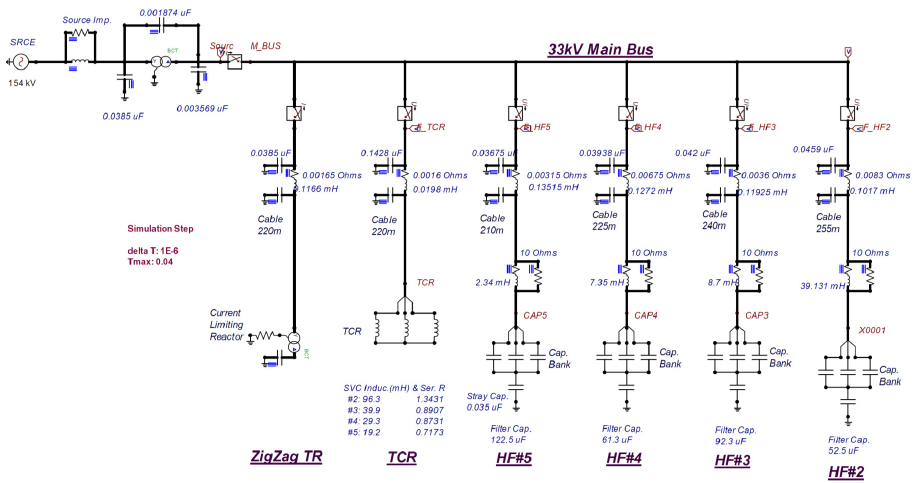
Figure 10. Schematic diagram of four multiple single-tuned filter banks for an electric arc furnace.